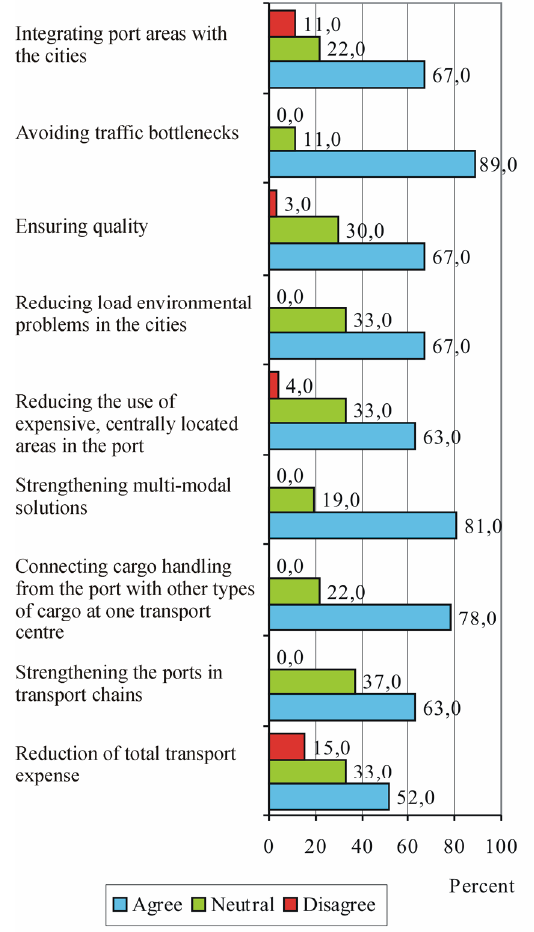
Fig 6. Average opinion on Dry port